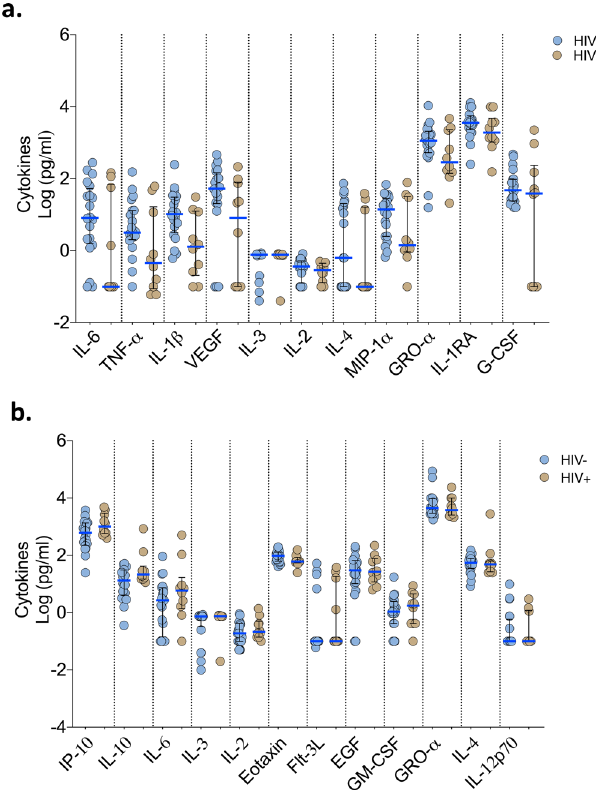
Fig. 6 Cytokine concentrations in nasal lining fl uid and serum based on HIV-co-infection status. PCR-con fi rmed COVID-19 and PCR − /IgG + SARI patients were combined ( n = 41) into one COVID-19 patient group. Only cytokines that showed differential responses between patients with healthy controls were included in the analysis. a Cytokine concentrations between HIV-infected and uninfected COVID-19 patients in nasal lining fl uid. b Cytokine concentrations between HIV-infected and uninfected COVID-19 patients in serum. The horizontal bars represent the median (blue line) and interquartile range (IQR) (black lines). Data were analysed using Kruskal – Wallis test (HIV − , n = 20; HIV + , n = 10). COVID-19 coronavirus disease of 2019, PCR polymerase chain reaction, SARI severe acute respiratory infection. Source data are provided as a Source Data fi